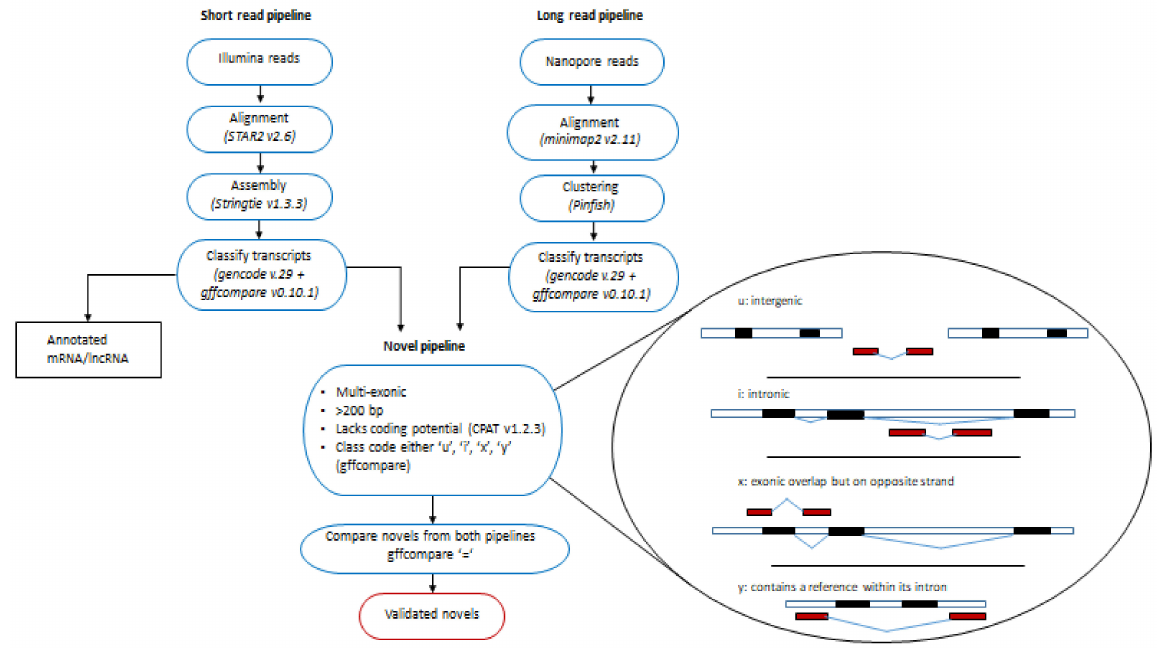
Figure 2. A schematic of the pipeline for novel lncRNA discovery (Illumina sequencing) and validation (Nanopore sequencing).